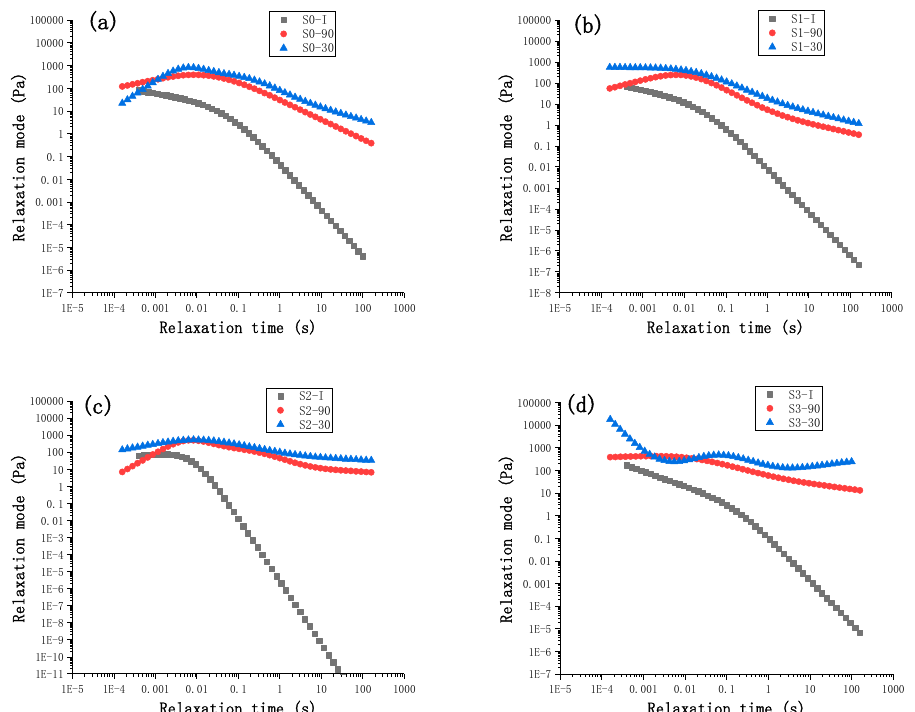
Figure 5. Relaxation time spectrum of ( a ) S0, ( b ) S1, ( c ) S2, ( d ) S3 film-forming solutions dried to different water